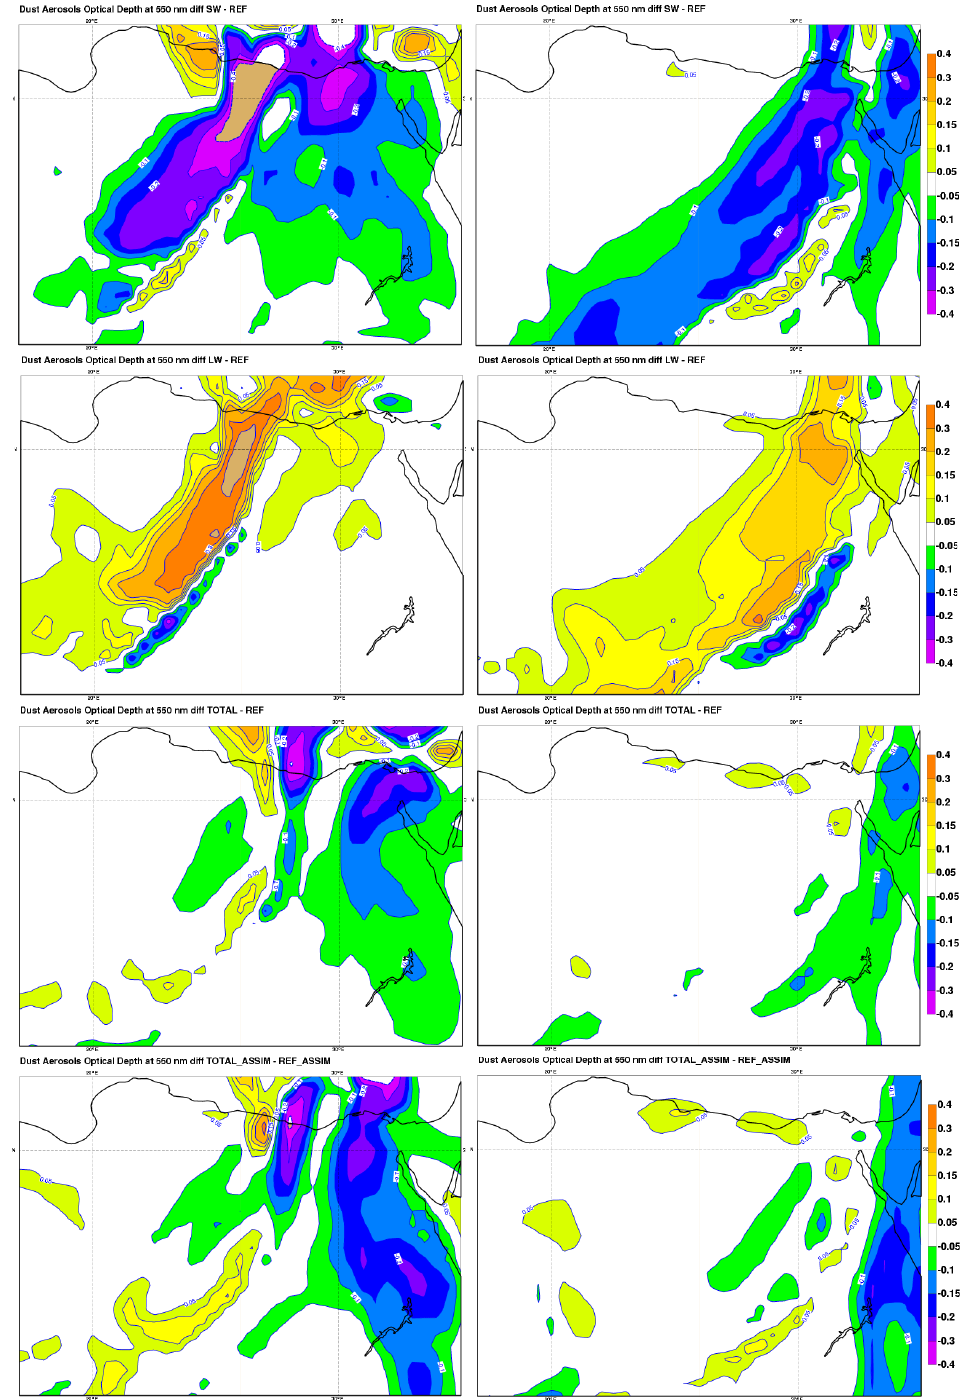
Figure 15. Simulations starting on 17 April 2012, 24h forecast (left) and 36h (right) forecast time. Difference of AOD at 550nm, SW–REF (top), LW–REF (middle top), TOTAL–REF (middle bottom) and TOTAL_ASSIM–REF_ASSIM